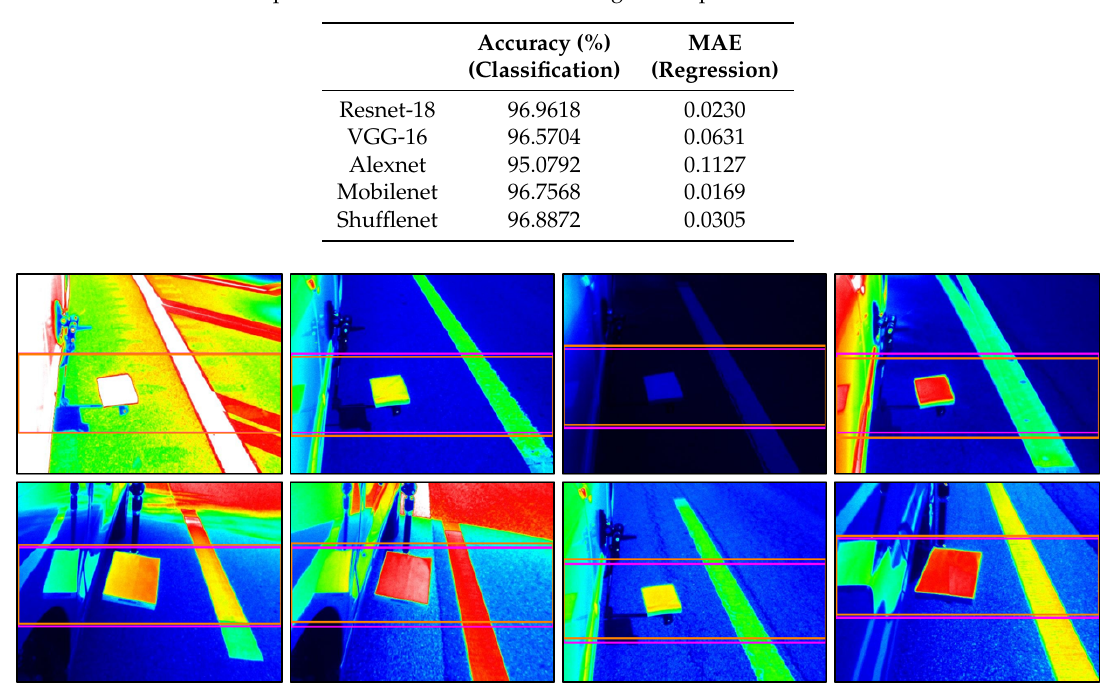
Table 2. Comparison of the classification and regression performance of each model.